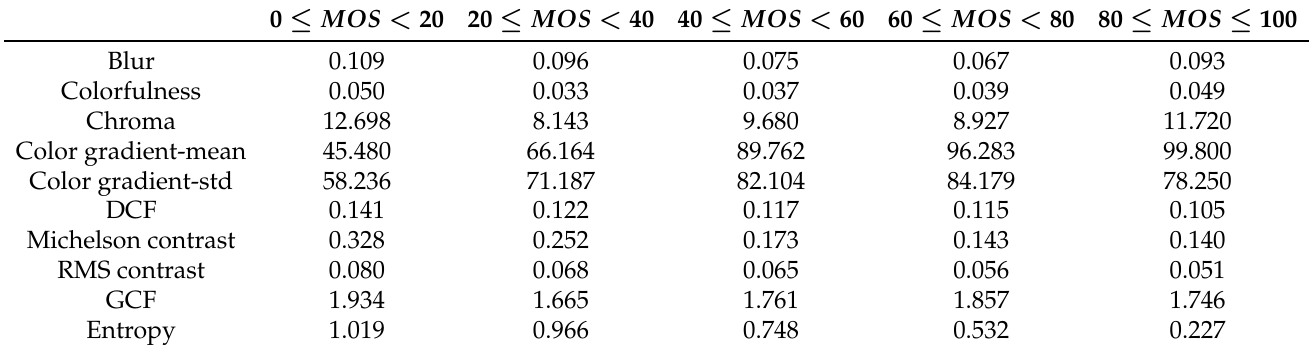
Table 5. Standard deviation values of perceptual features in CLIVE [45] with respect to five equal MOS